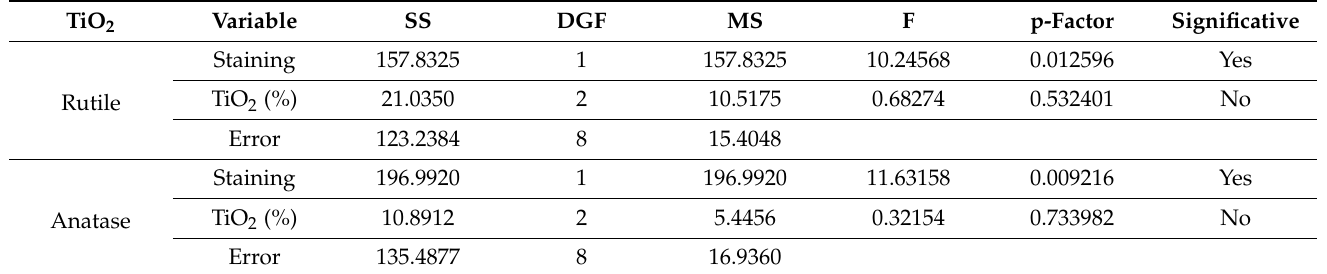
Table 7. Main effects analysis of variance on tiles produced with TiO 2 rutile and anatase, with and without staining by methylene blue, subjected to UVA radiation.